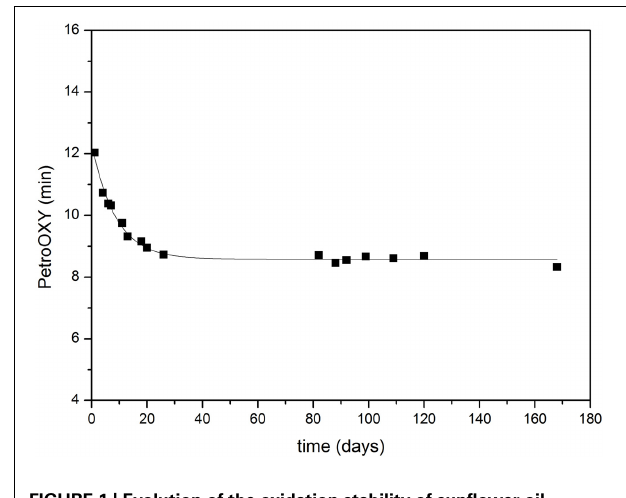
FIGURE 1 | Evolution of the oxidation stability of sunflower oil biodiesel over time determined with the PetroOXY method. ( (cid:2) biodiesel